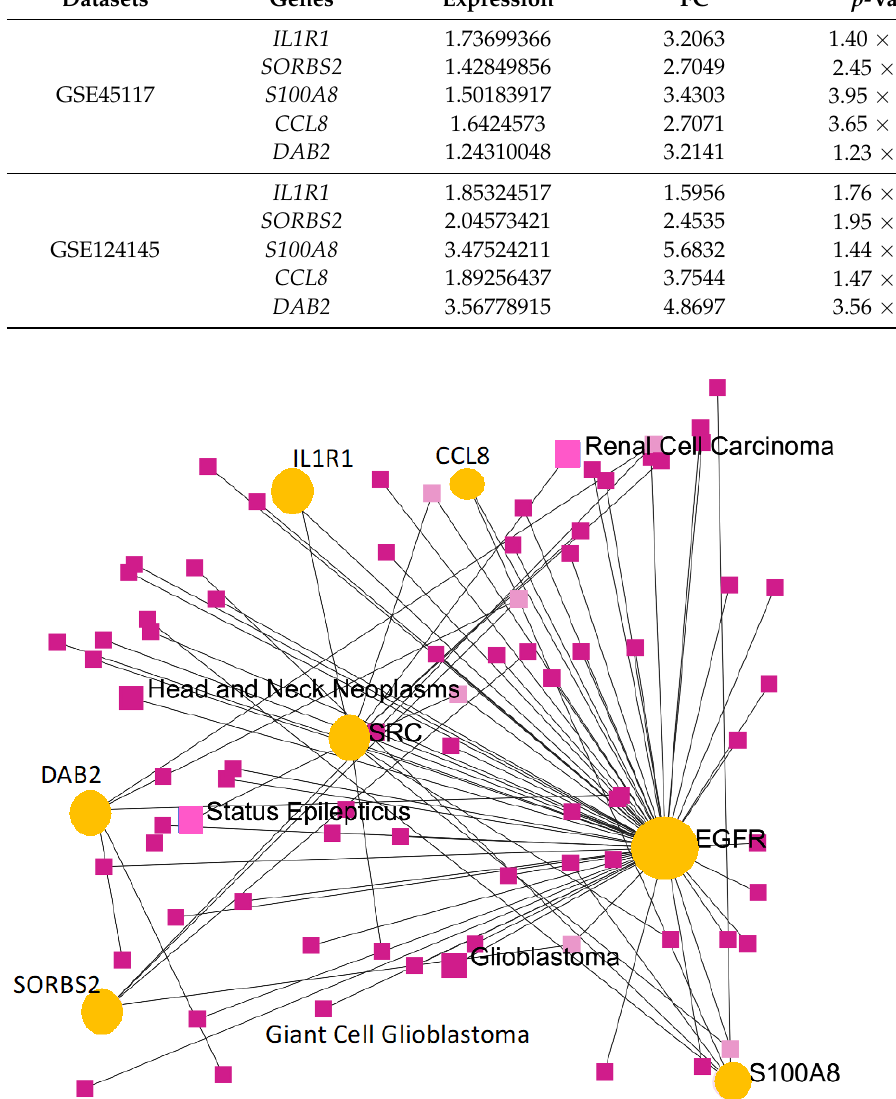
Figure 9. A gene-disease association network of the most common hub genes of co-expression.